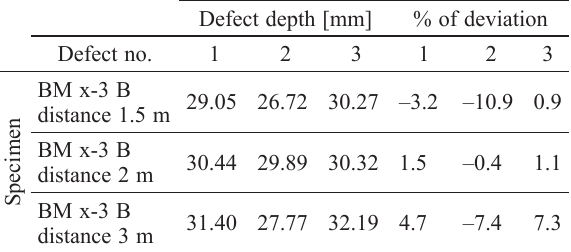
Fig. 18. Optimal thermogram; BM 2-3, Fig. 19. 2 nd derivative of the thermal bottom side, distance 2 m contrast evolution, bottom side, specimen BM 2-3, distance 2 m Table 2. Average defect depth for the specimen BM x-3 Defect depth [mm] % of deviation Defect